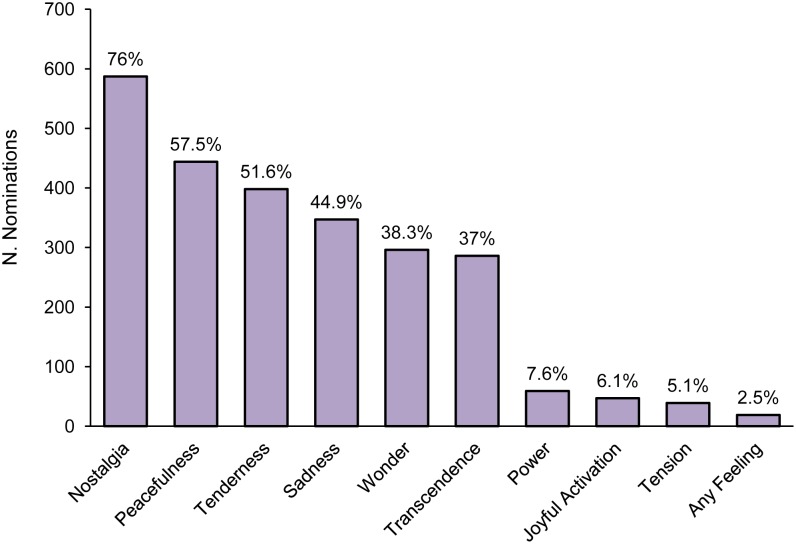
The most frequent emotions, as measured by the GEMS, evoked in response to sad music.